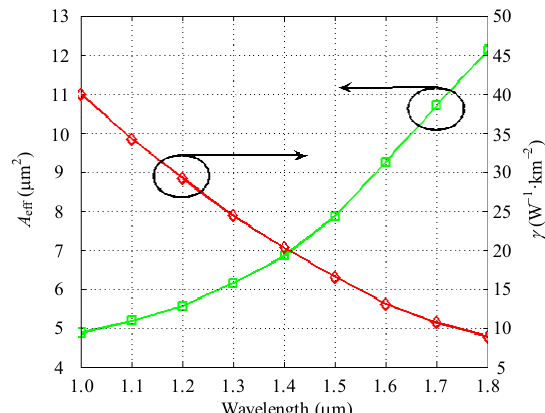
Fig. 9 Effective area and nonlinear coefficient of the x -polarization mode of the proposed H-PCF as a function of wavelength for  = 3.00  m;  c = 1.08  m; d = 2.85  m, d c = 0.774  m, and d c 0 = 1.08  m.